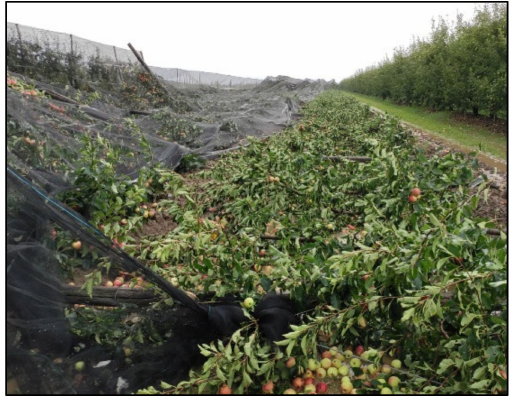
Figure 1. An apple orchard (cultivar “Gala”) with hail nets uprooted by the storm on 12 August 2020. At the bottom, many mature apples can be noted, suggesting the economic loss caused by the